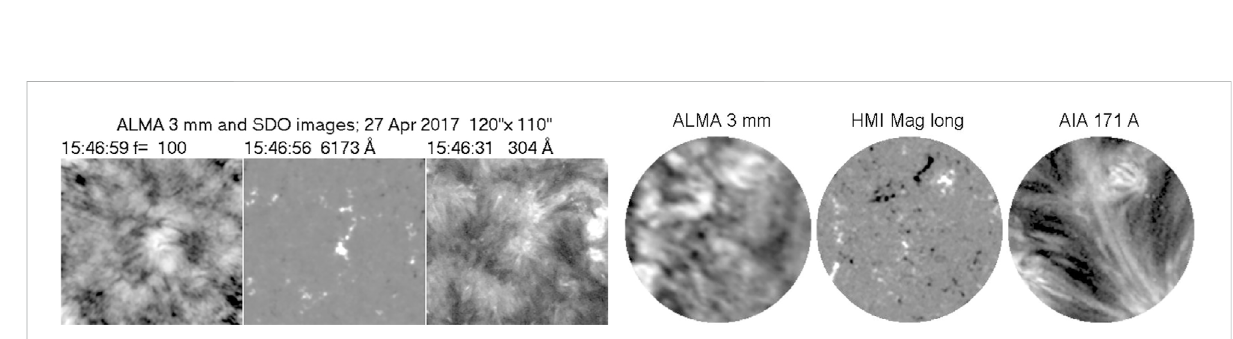
FIGURE 13 ALMA images at 3 mm. Left: A low intensity region at 3 mm from data used by Loukitcheva et al. (2019), together with an HMI magnetogram saturated at ± 200 G and a 304 Å AIA image (prepared by the authors using data from ALMA project 2016.1.00202. S and from SDO). Right: A quiet regionat3 mmtogetherwithanHMImagnetogramanda171 ÅAIAimage;thediameterofthe fi eldofviewis~ 67 ′′ (adaptedfromWedemeyeretal.,